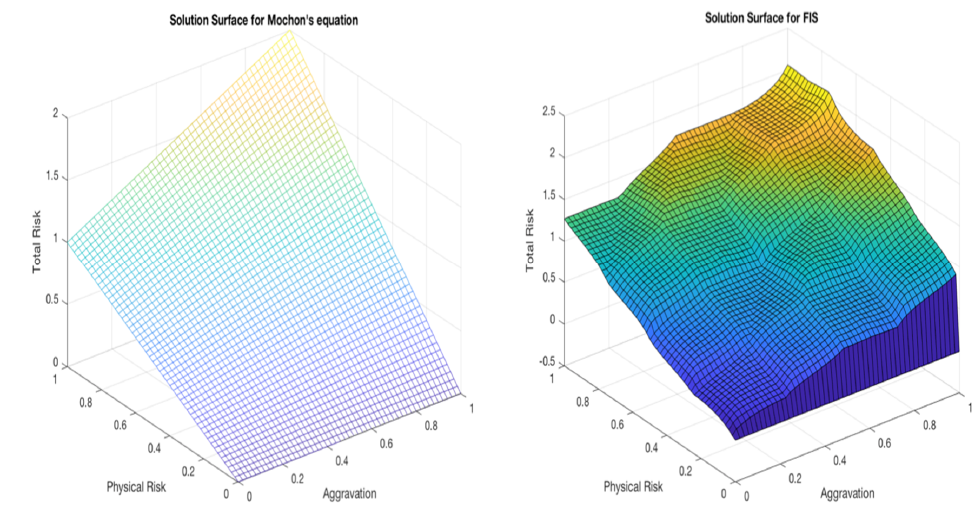
Figure 3. Appl. Sci. 2020 , x , x FOR PEER REVIEW